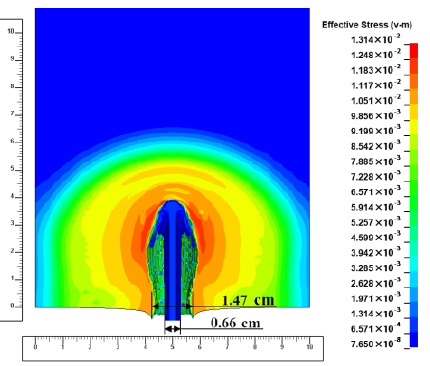
Figure 4. Schematic diagram of the ejecta aperture at the early stage of pit opening. After that, the energy of each jet micro-element decreases continuously with the presence of the velocity gradient due to the decrease in the velocity of the subsequent jet micro-element and the relative decrease in the pressure at the contact position of the jet target plate. As a result, the remaining energy after the axial penetration of the jet is completed becomes smaller and smaller during the penetration of the target slab. In addition, due to the severe plastic deformation of the target plate during the hole opening, a local hardening of the target plate is induced, which also increases the re- sistance of the target plate to the radial extension of the jet. Under the combination of the above two effects, the radial re-emission diameter of the jet decreases, as shown in Fig- ure 5. Therefore, there is an extreme value of the jet reaming diameter during the pit- opening phase. Figure 5. Schematic diagram of the jet aperture at the later stages of the pit-opening. Since the hole digging process only accounts for a limited part of the total jet pene- tration process, the subsequent penetration enters the quasi-steady stage, and the energy gradient of the jet in this part is relatively slow and the residual energy of the jet micro- element in this part mainly remains stable after the completion of the axial penetration. Moreover, the amplitude of the material hardening in the quasi-steady region is inferior to that in the hole-opening phase, so that the aperture opened by the hole-expanding jet is mainly non-shifting with time and remains stable, as shown in Figure 6.